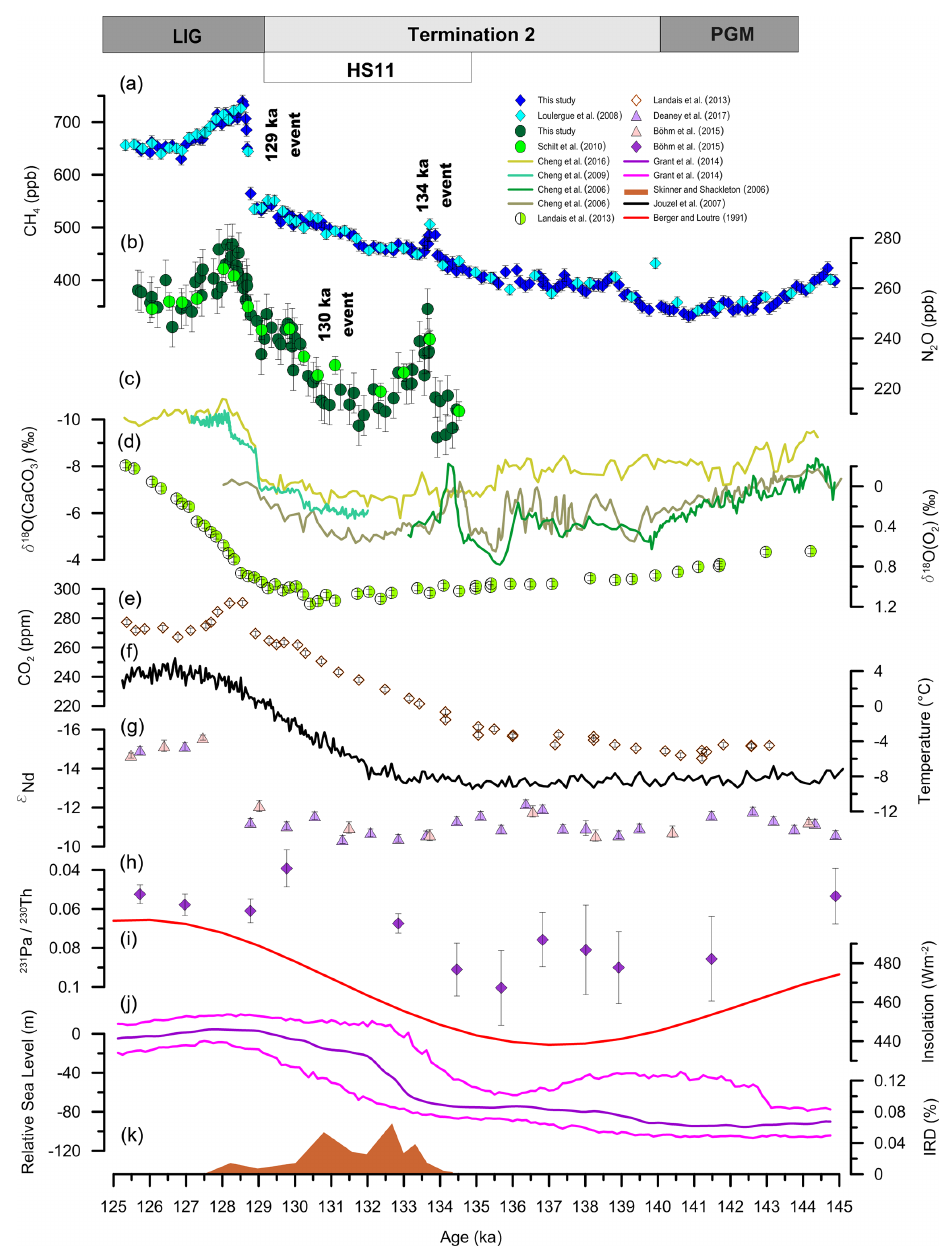
Figure 2. Evolution of the CH 4 and N 2 O concentrations combined with complementary climate proxies during TII. The boxes delineate the climate periods mentioned in the text: the Penultimate Glacial Maximum (PGM), Heinrich Stadial 11 (HS11, delineation according to Marino et al., 2015), and the Last Interglacial (LIG). (a) Composite CH 4 record. (b) Composite N 2 O record. (c) Speleothem δ 18 O (CaCO 3 ) records: Sanbao SB25 (light green) (Cheng et al., 2009), Hulu Cave MSX (khaki) (Cheng et al., 2006), Hulu cave MSP (dark green) (Cheng et al., 2006), and Sanbao–Dongge composite (pale yellow) (Cheng et al., 2016). (d) δ 18 O (O 2 ) from EDC on the AICC2012 timescale (Landais et al., 2013). (e) CO 2 from EDC on the AICC2012 timescale (Landais et al., 2013). (f) Antarctic surface temperature (relative to the last millennium) from EDC on the AICC2012 timescale (Jouzel et al., 2007). (g) Composite ε Nd from the sediment core ODP Site 1063 (Deaney et al., 2017), including data points from Böhm et al. (2015) (purple) and new measurements from Deaney et al. (2017) (pale pink), on the timescale of Deaney et al. (2017). (h) 231 Pa / 230 Th record from the sediment core ODP Site 1063 (Böhm et al., 2015), on the timescale of Deaney et al. (2017). (i) Mean summer (June to August) insolation at 40 ◦ N (Berger and Loutre, 1991). (j) Relative sea level stand from the Red Sea synchronized on a radiometric timescale, including the maximum probability curve (purple) and its 95% confidence interval (magenta) (Grant et al., 2014). (k) Ice-rafted debris (IRD) from Skinner and Shackleton (2006) on the radiometric timescale of Marino et al.